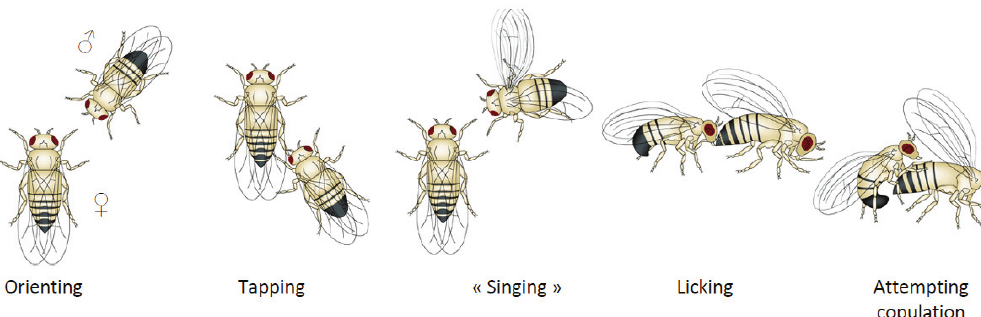
Figure 1. Sequence of sexual courtship ritual in Drosophila (adapted from